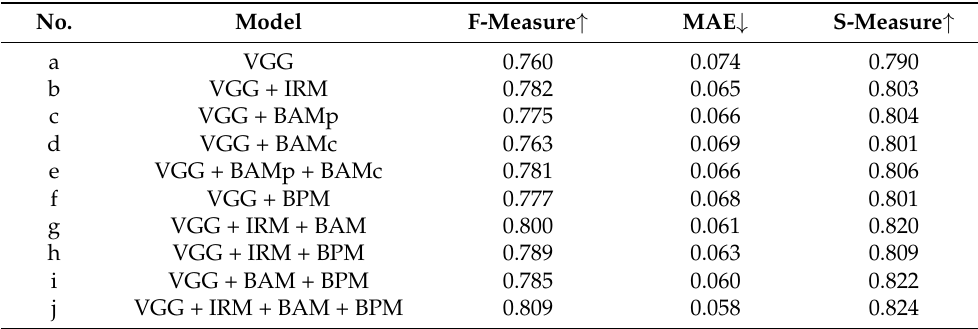
Table 1. Ablation analysis on the DUTS-TE datasets. BAMp is the BAM submodule at the position, BAMc is the BAM submodule at the channel, and BAM means BAMp+BAMc.